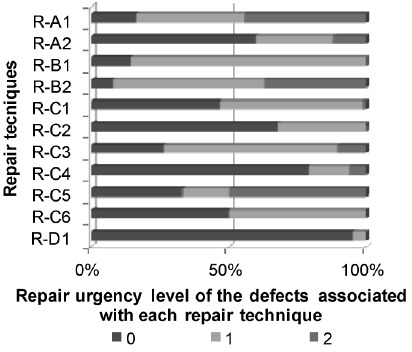
Fig. 15. Repair urgency level of the defects associated with each repair